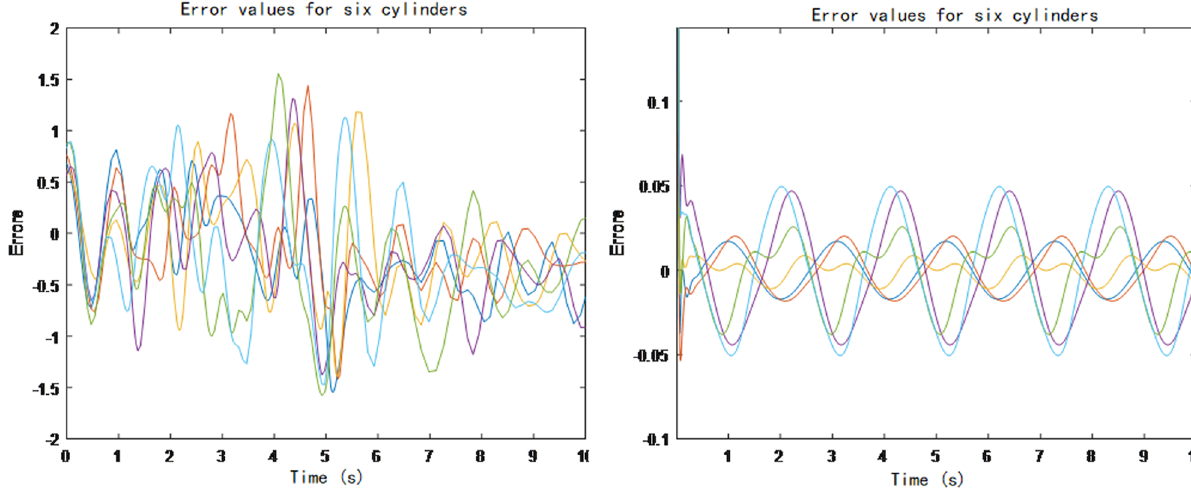
Figure 6. Errors obtained from the wave compensation platform test.